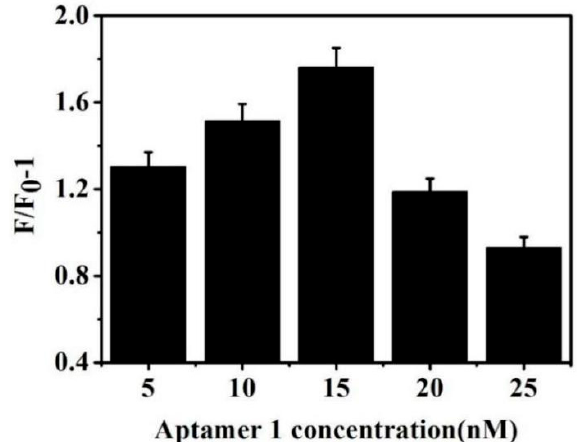
Figure 5. Effect of different concentrations of aptamer 1 on fluorescence intensity.